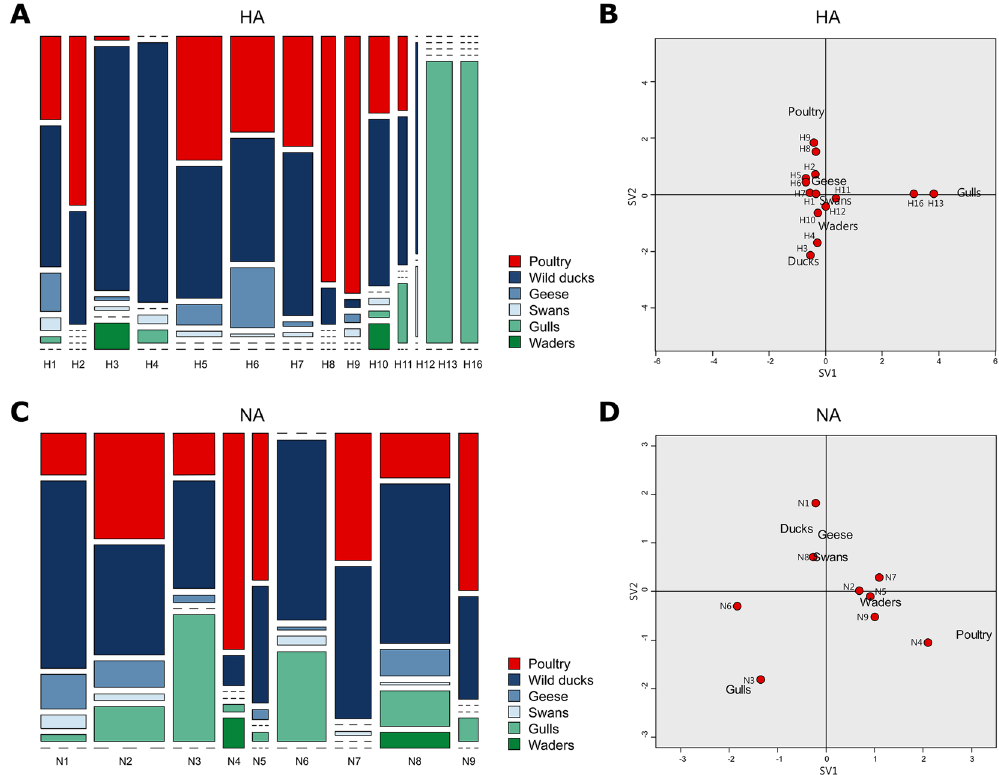
Figure 3. Virus subtype distribution among wild bird species and poultry. ( A ) Relative hemagglutinin (HA) subtype distribution among wild bird species and poultry. The bar width represents the number of cases within each HA subtype. ( B ) Correspondence plot showing the association between bird species and HA subtype in two dimensions (singular value (SV)1 and SV2). ( C ) Relative neuraminidase (NA) subtype distribution among wild bird species and poultry. The bar width represents the number of cases within each NA subtype. ( D ) Correspondence plot showing the association between bird species and NA subtype in two dimensions (SV1 and SV2). All subtyped cases were detected as part of the national avian influenza (AI) surveillance program in the Netherlands, January 2006-September